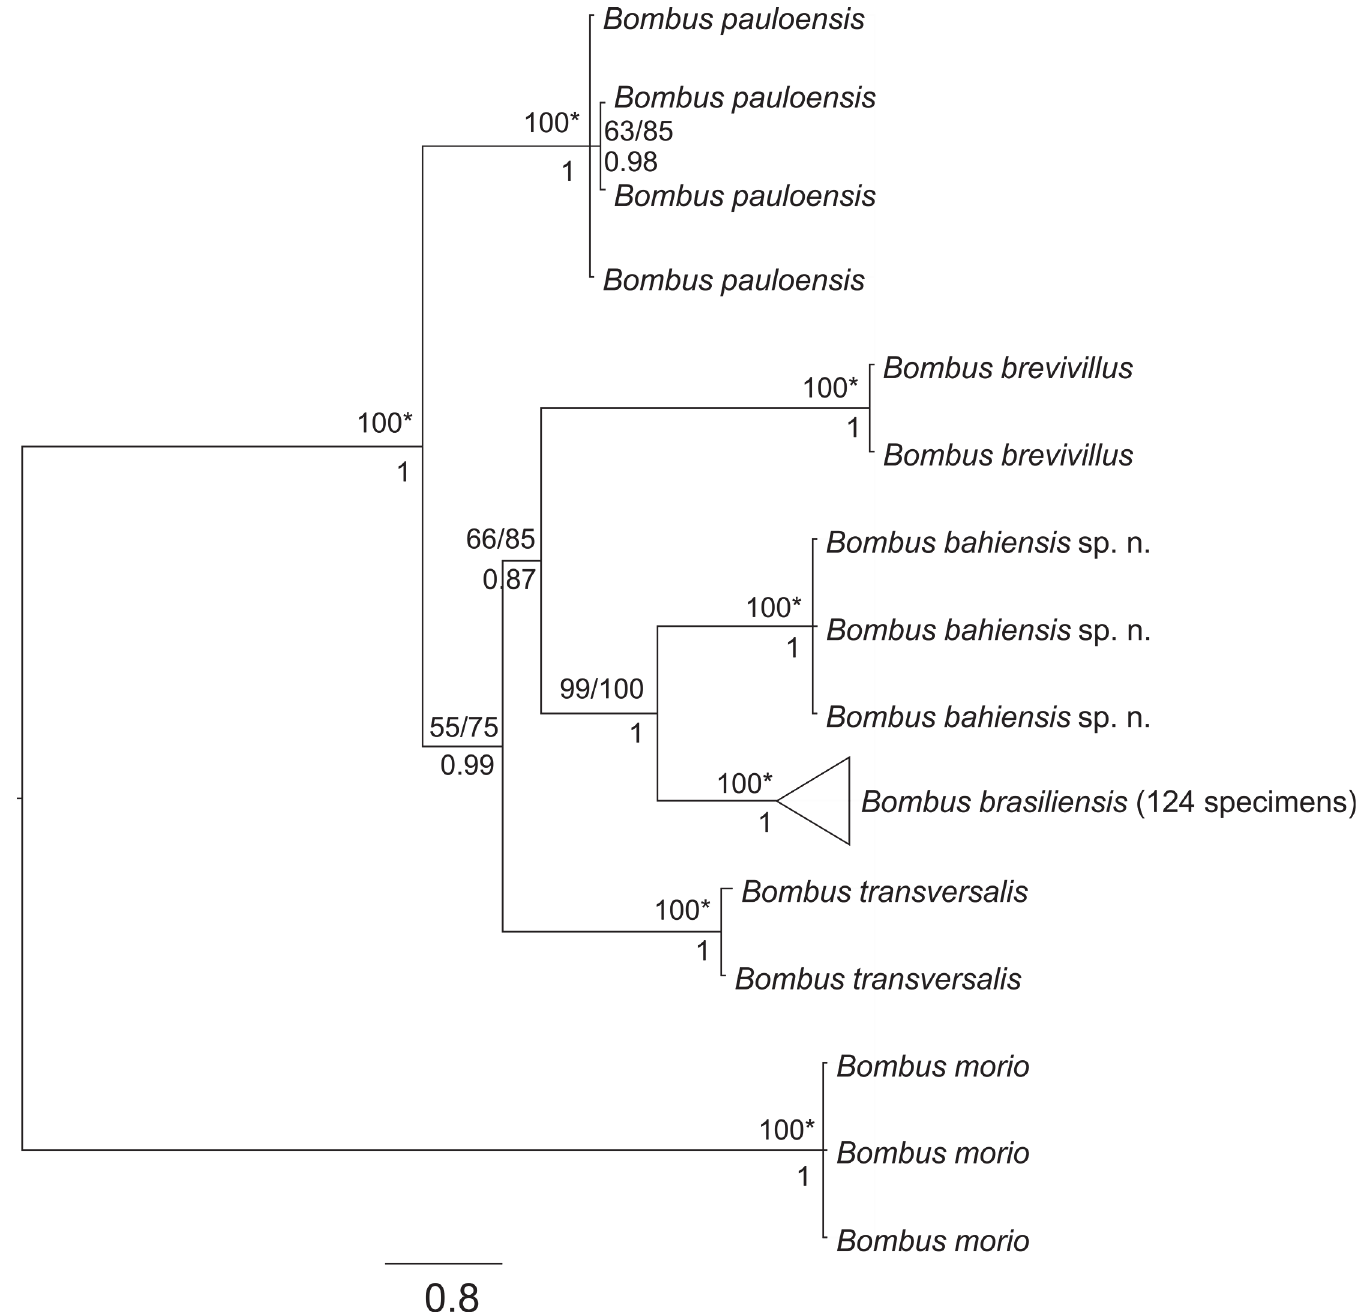
Fig 4. Phylogenetic relationships among Brazilian bumblebees obtained from concatenated phylogenetic analyses performed with CytB and COI sequences, using Bayesian inference and all specimens available for each species. Values shown under each branch are posterior probabilities. The values shown above each branch are bootstrap values represented here by Maximum Parsimony (MP)/ Maximum Likelihood (ML), because an identical topology was obtained with MP and ML. An analysis employing only unique haplotypes yields the same topology. “ * ” Represents the same values for MP and ML. Bombus morio (Swederus, 1787) was used as outgroup. The collapsed branch includes all Bombus brasiliensis haplotypes found on the haplotype network from Fig 2 and S1